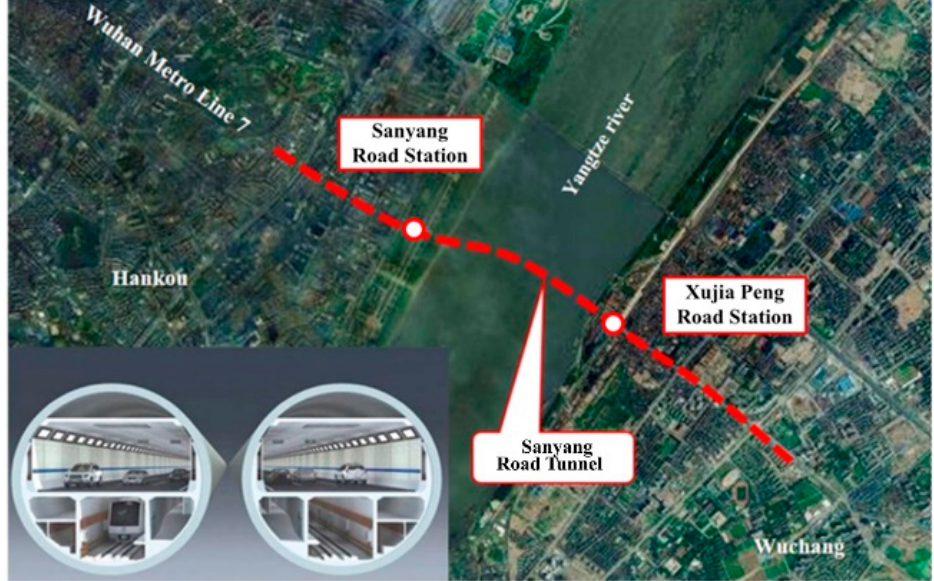
Figure 1. San-yang Road Yangtze River tunnel in Wuhan Metro Line 7. Table 1. Physical and mechanical parameters of silty sand.